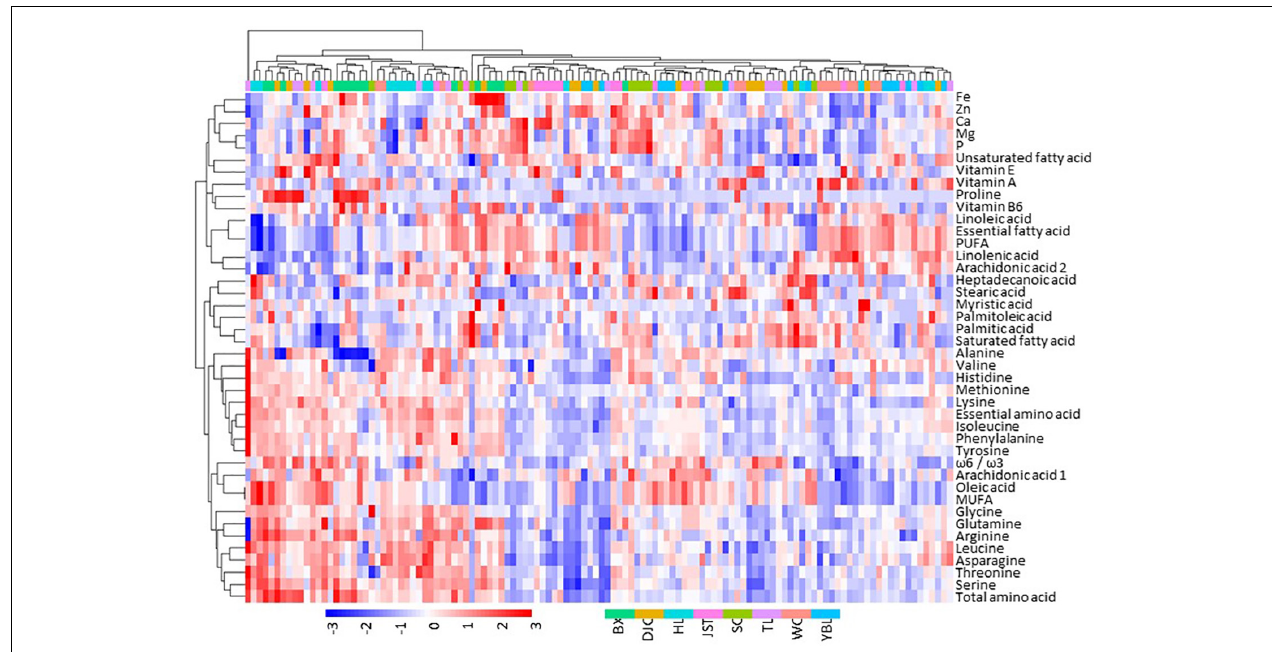
FIGURE 4 | Heatmap showing the distribution of major components in J. mandshurica kernel. Nutritional composition data were scaled by subtracting the mean. Thus, positive values indicate above the mean (red), and negative values indicate below the mean (blue). Data of individual trees from each site, color coded as shown in the bottom of the figure, were used. BX, Binxian, HLJ; DJC, Ning’an, HLJ; HL, Hulin, HLJ; JST, Yichun, HLJ; SC, Baishan, JL; TL, Tieli, HLJ; WC, Wuchang, HLJ;YBL, Yabuli, HLJ. HLJ, Heilongjiang province; JL, Jilin